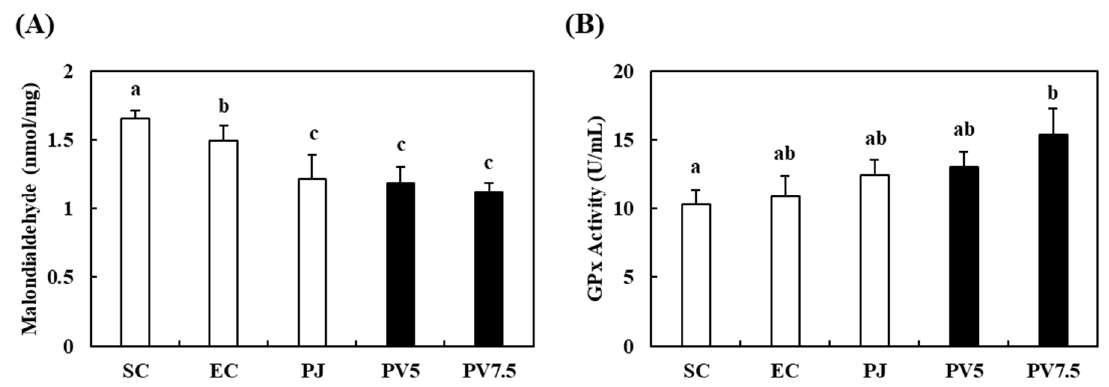
Figure 7. E ff ects of PV on ( A ) malondialdehyde and ( B ) glutathione peroxidase activities in rats exhausted by exercise. Data values are expressed as the means ± S.E. ( n = 6). SC: sedentary control, EC: exercised control, PJ: Prunus mume juice, PV5: 5% Prunus mume vinegar drink, PV7.5: 7.5% Prunus mume vinegar drink. Di ff erent letters on the bar are significantly di ff erent ( p < 0.05).